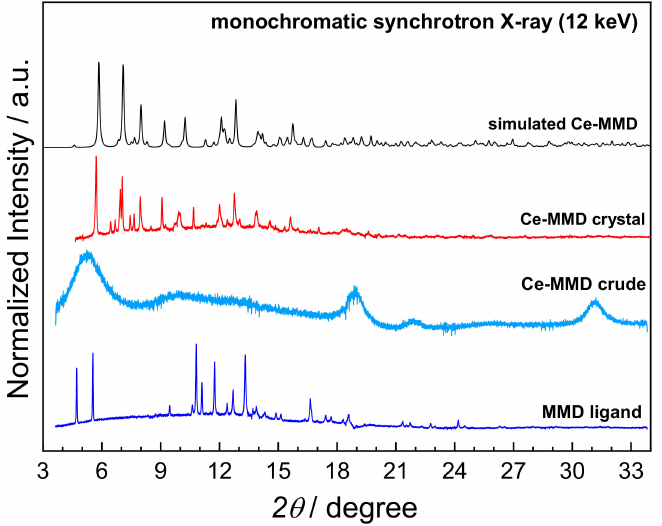
Figure 12. Comparison of powder X-ray diffraction (XRD) patterns of the MMD ligand (blue), the Ce-MMD crude (dark cyan), the Ce-MMD crystal (red), and the simulated XRD pattern of Ce-MMD based on the SC-XRD data